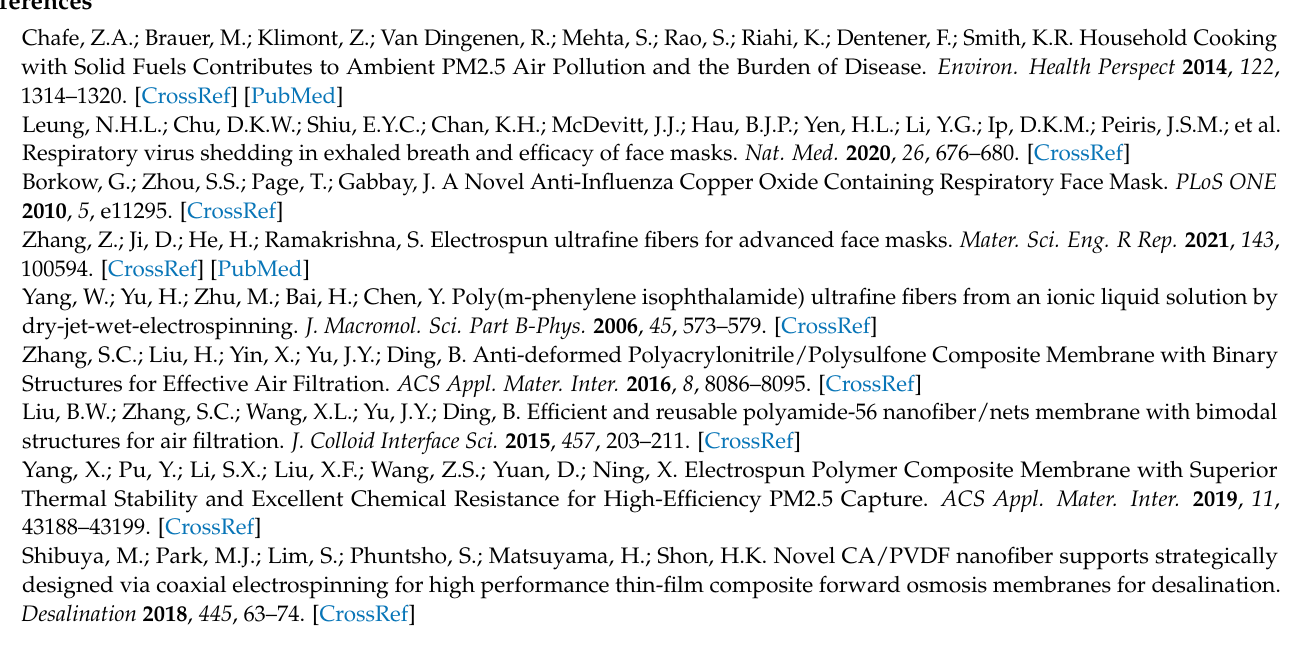
Figure S3: Diameter distribution of (a) CA fibers, (b) CA/TPU fibers, and CA/TPU-xLiCl fibers and (f) 3 wt%; Figure S4: Illustration showing the 3D model and dust particles filtration of CA/TPU and CA/ TPU-1LiCl films; Figure S5: 3D simulation of filtration efficiency and pressure drop of CA/ TPU-1LiCl fibrous films with different gram weight; Figure S6: 3D simulation of filtration efficiency and pressure drop of CA/ TPU-1LiCl fibrous film at different gas